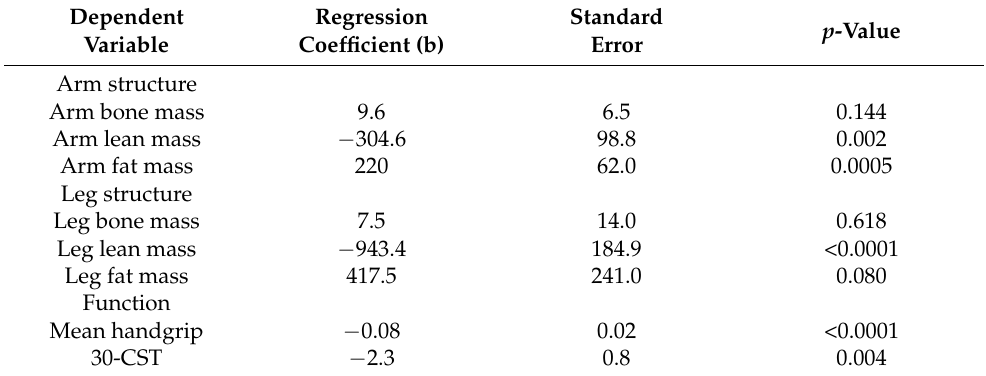
Table 2. Mean estimated difference of body structure and function in ERA, compared to controls *.